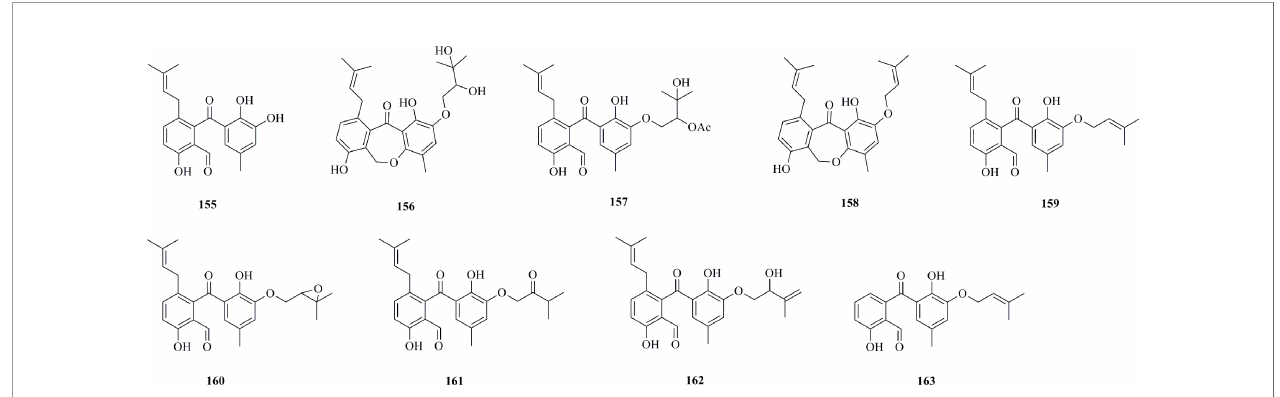
FIGURE 9 | Benzophenones isolated from deep-sea fungi ( 155 − 163